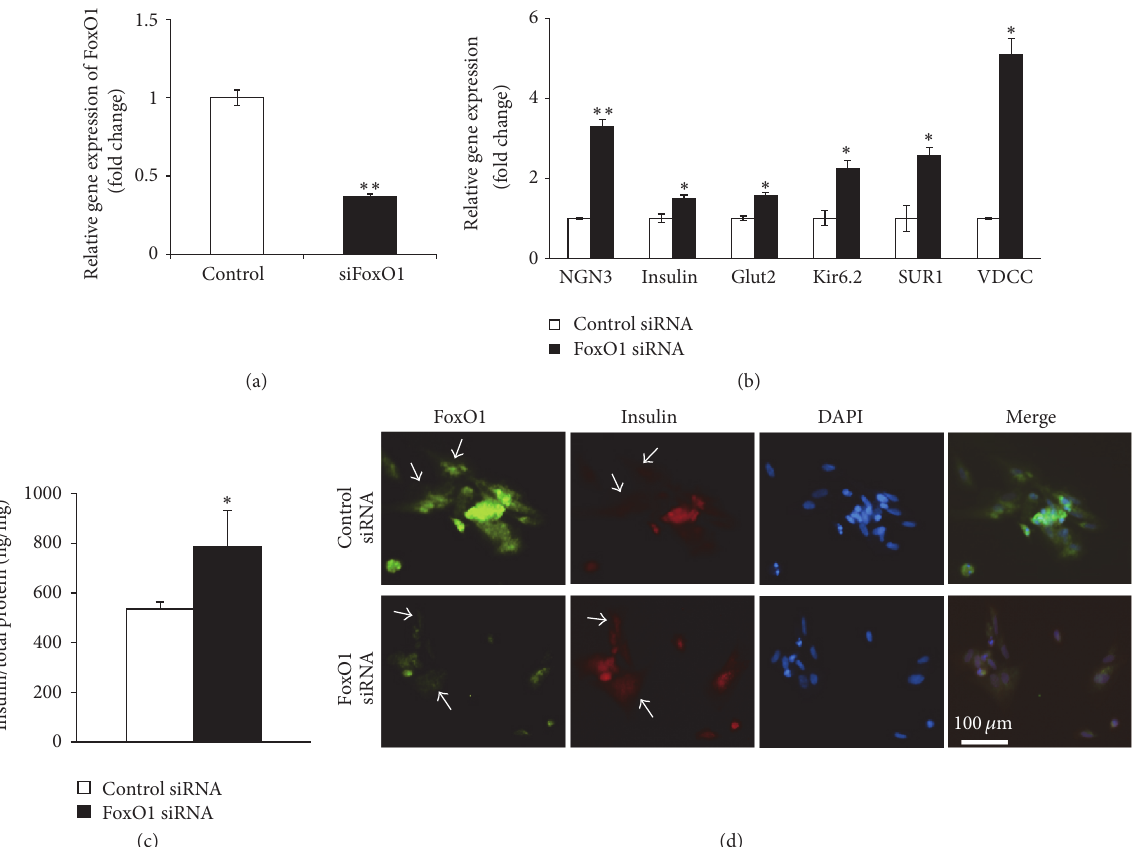
Figure 3: Knockdown of FoxO1 results in increased expression of 𝛽 cell markers. (a) qRT-PCR analysis of FoxO1 mRNA levels in human pancreaticprogenitorcellstransfectedwithscrambleorFoxO1siRNAfor48 h.Datawerenormalizedagainstthelevelof 𝛽 -actinandexpressed as fold change relative to scramble siRNA group. Values are means ± SEM of 4 independent experiments per each group. ∗∗ 𝑝 < 0.01 . (b) qRT-PCR analysis of 𝛽 cell markers in human pancreatic progenitor cells transfected with scramble or FoxO1 siRNA for 48 h. Data were expressed as fold change relative to scramble siRNA group and are means ± SEM of 4 to 5 independent experiments. ∗ or ∗∗ , 𝑝 < 0.05 or 0.01. (c) Insulin content analysis by ELISA for human fetal progenitor cells, respectively, transfected with FoxO1 siRNA or control siRNA. Values were normalized to total protein content. ∗ 𝑝 < 0.05 . (d) Immunohistochemistry with antibodies against FoxO1 (green, dilution of 1: 100) and insulin (red, dilution of 1:100) in the human fetal progenitor cells, respectively, transfected with FoxO1 siRNA (under panels) or control siRNA (upper panels). Arrows indicate the FoxO1 knockdown cells where the insulin was also decreased. Bar = 100 um.